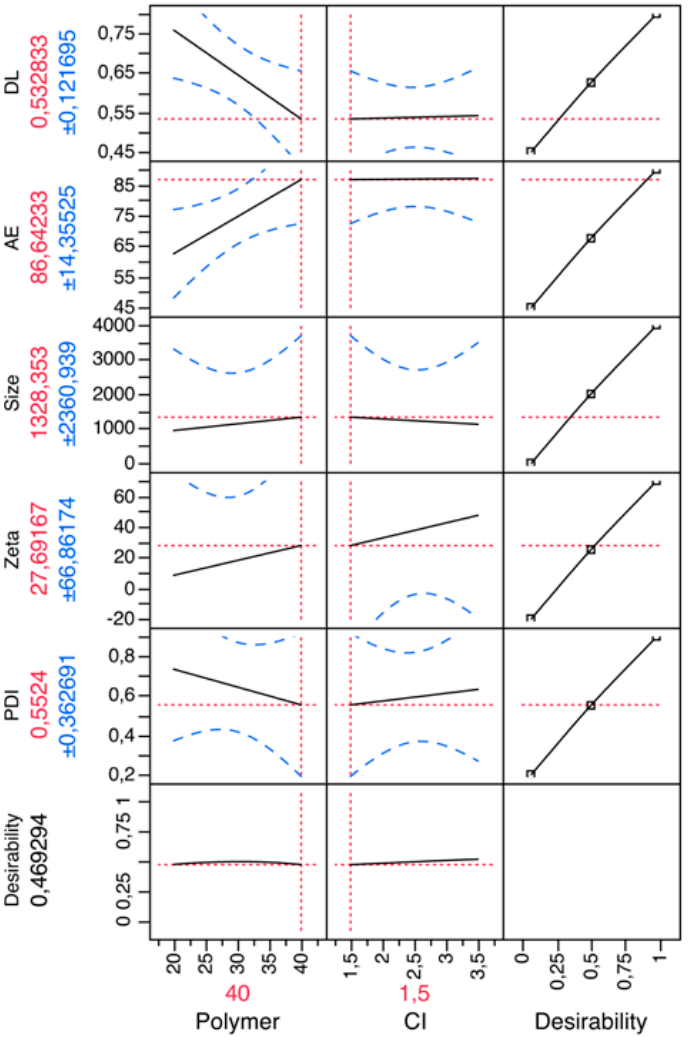
Figure 1. Prediction profiler for chitosan (CH) microparticles (MPs). X ‐ axis: polymer (CH) (mg), counter ‐ ion (TPP) (mg); Y ‐ axis: polydispersity index (PDI), zeta potential (mV), size (nm), association efficiency (AE), drug loading (DL).